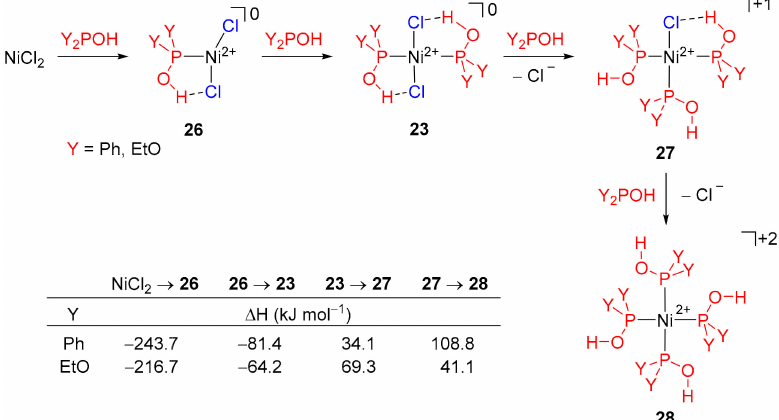
Scheme 12. Ligation of NiCl 2 with > P(O)H species together with complexation energies computed